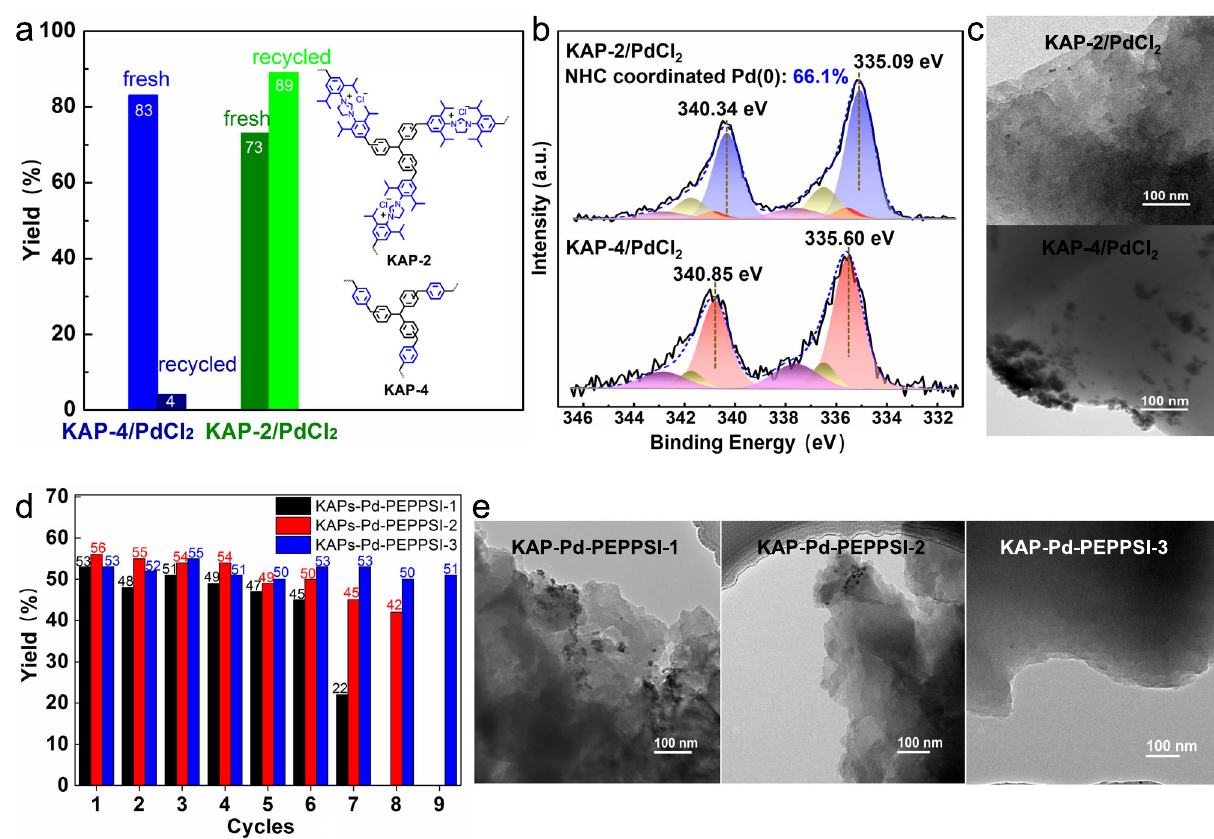
Fig. 4 Stabilizing effect of KAP. a Control experiments to determine the stabilizing effect of NHC under the optimized reaction conditions. b Pd XPS spectra and c TEM images of recycled KAP-2/PdCl 2 and KAP-4/PdCl 2 . d Control experiments to determine the stabilizing effect of catalyst structure. Reaction conditions: 1a (0.25 mmol), CsF (1 mmol), Pd catalyst (2.5 mol%), I 2 (0.3 mmol), base (0.5 mmol), DMF (2 mL), 80 °C, 16 h, 2.0 MPa. e TEM images of different KAP-Pd-PEPPSI-x after the 6th